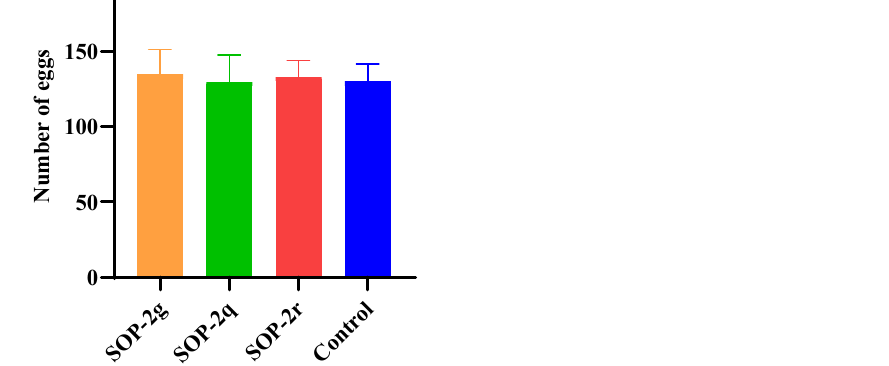
Figure 3. Effects on the fertility of female adult mosquitoes of Ae. albopictus .